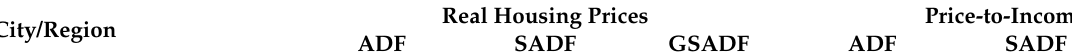
Table 2. Results for the Univariate ADF, SADF and GSADF